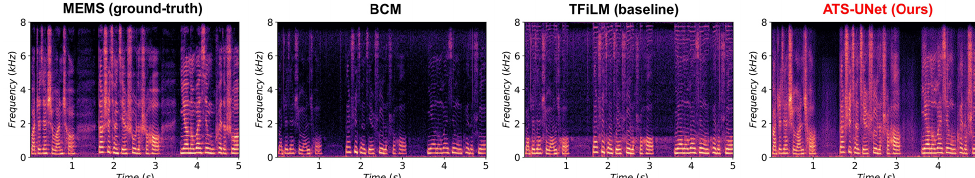
Figure 8. Audio super-resolution results visualized by